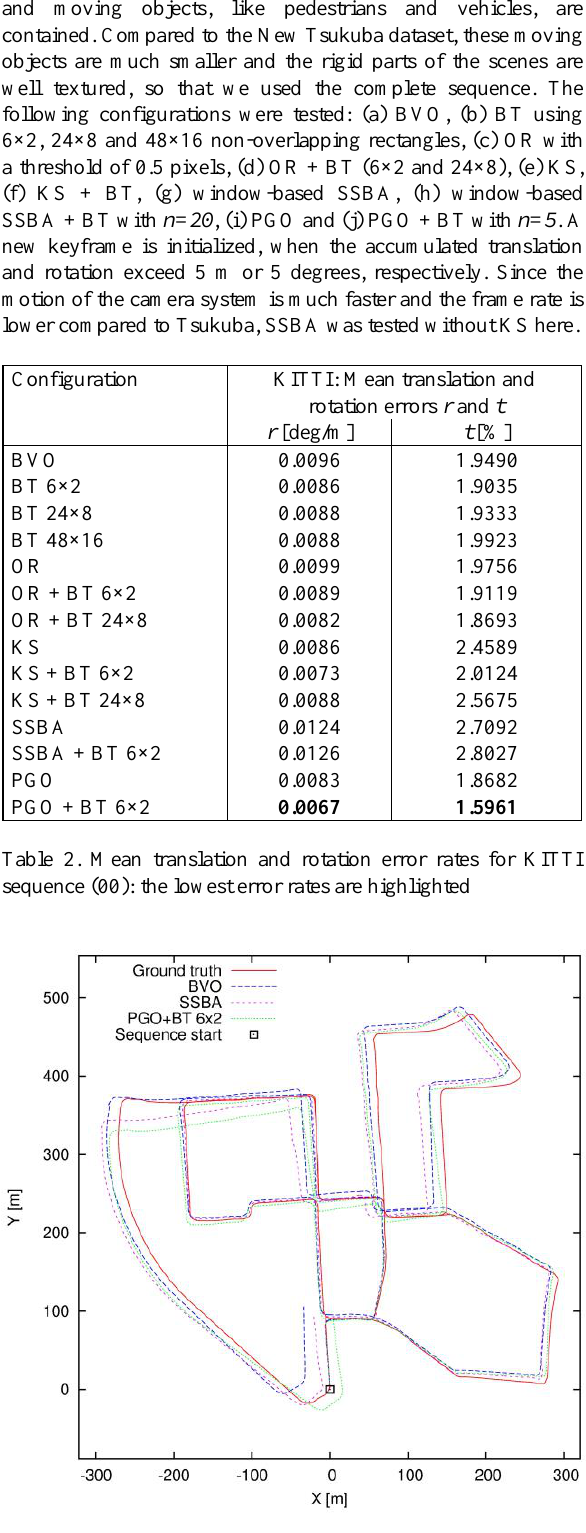
Figure 3. Selected result trajectories for New Tsukuba